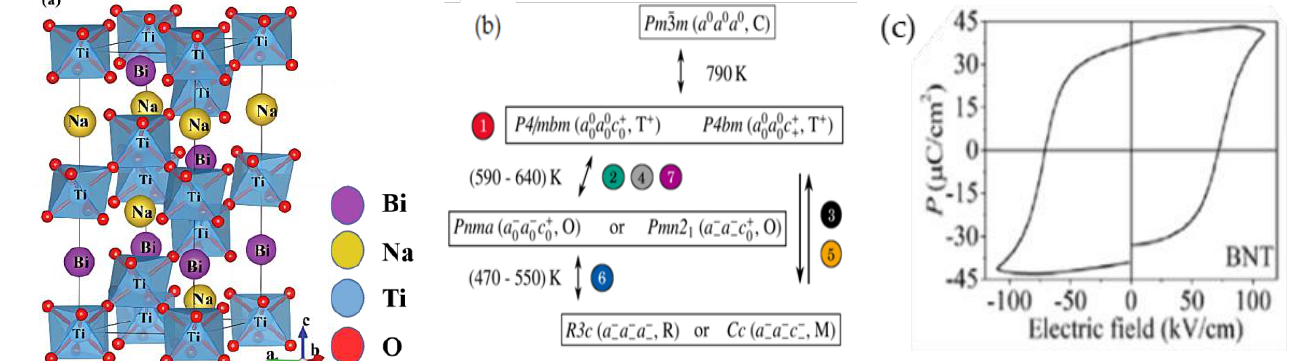
Figure 1. ( a ) Schematic of the BNT perovskite structure [8]. ( b ) Reported phase transitions in BNT [10]. ( c ) The P − E loop of BNT [11].